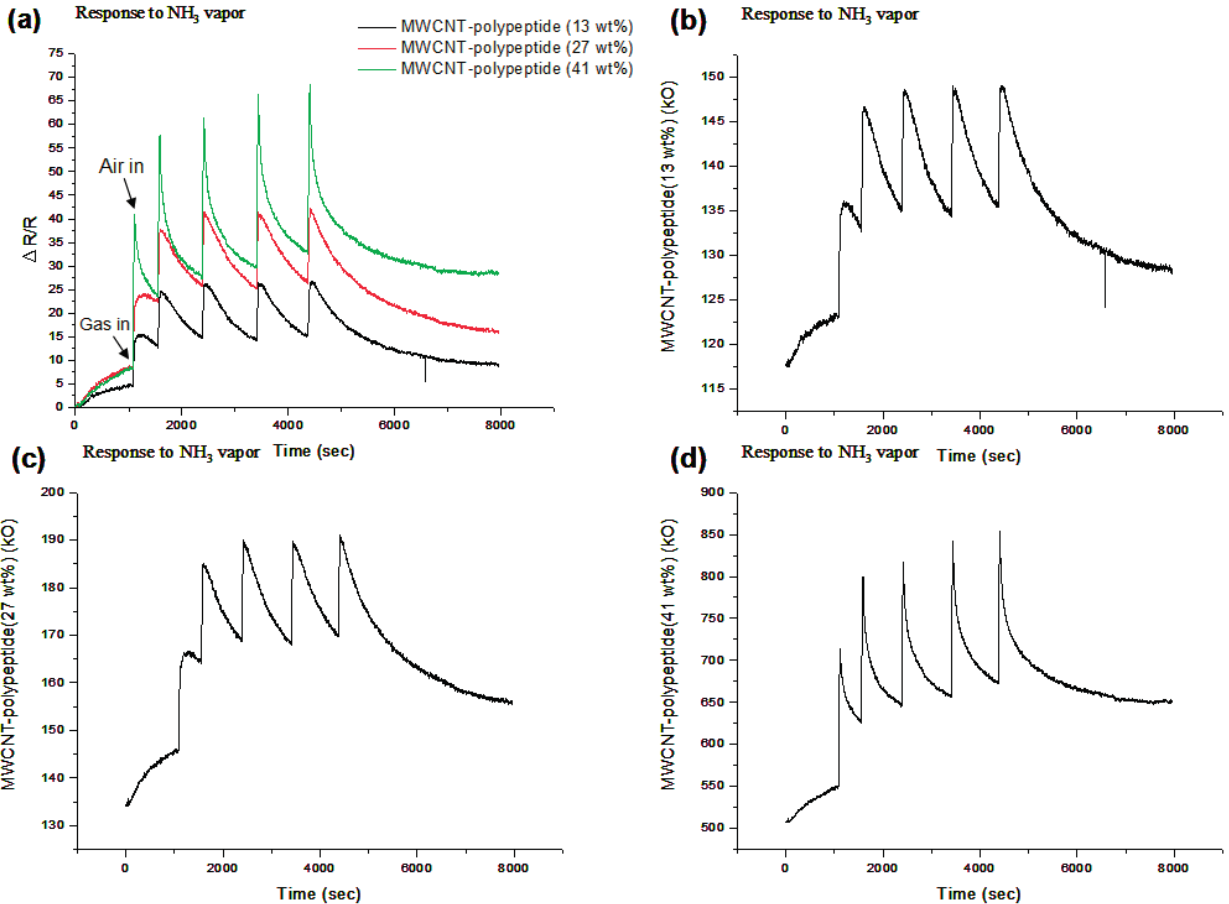
Figure 4. Gas sensing responses to NH 3 gas (283 ppm) of ( a ) MWCNT-polypeptide composite films with polypeptide concentrations of 13.0 wt%, 27.0 wt%, and 41.0 wt%; ( b ) MWCNT-polypeptide (13.0 wt%) composite films; ( c ) MWCNT-polypeptide (27.0 wt%) composite films; and ( d ) MWCNT-polypeptide (41.0 wt%) composite